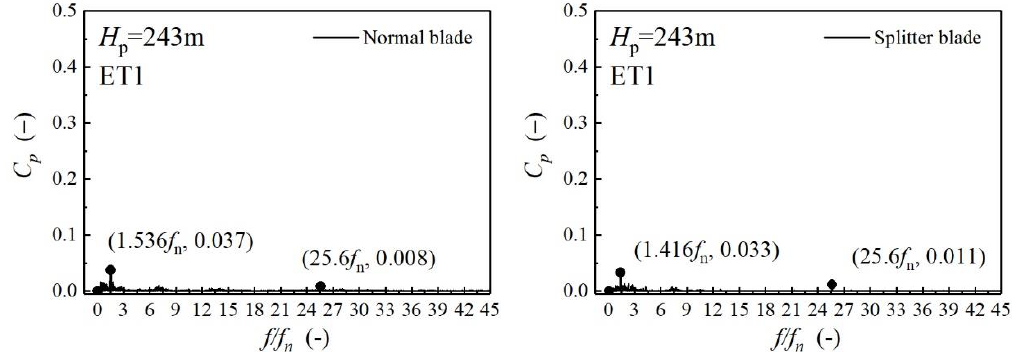
Figure 18. Frequency characteristics in cone of draft tube at 243 m head.